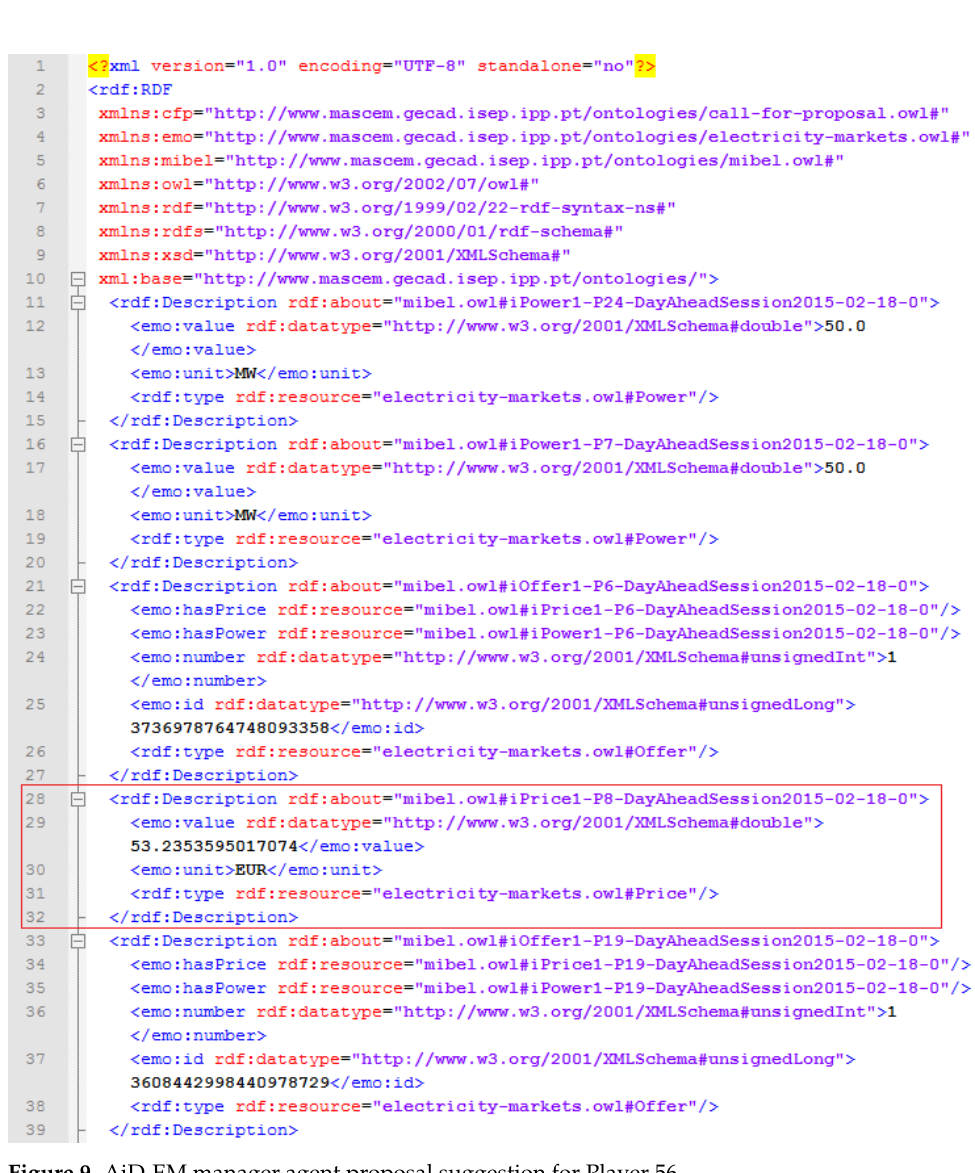
Figure 9. AiD-EM manager agent proposal suggestion for Player